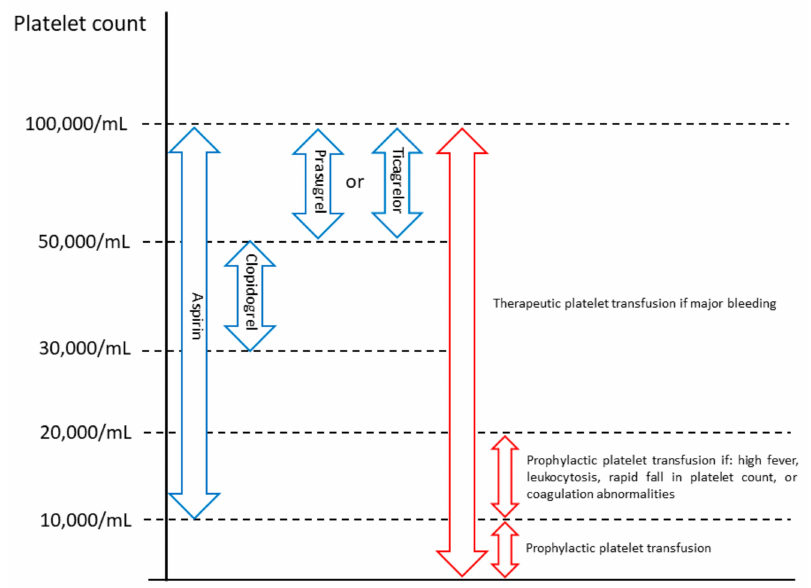
Figure 3. Management of antiplatelet therapy in cancer patients with acute coronary syndrome and thrombocytopenia (platelet count < 100,000 / mL) and no active bleeding, suggested by the Society for Cardiovascular Angiography and Interventions